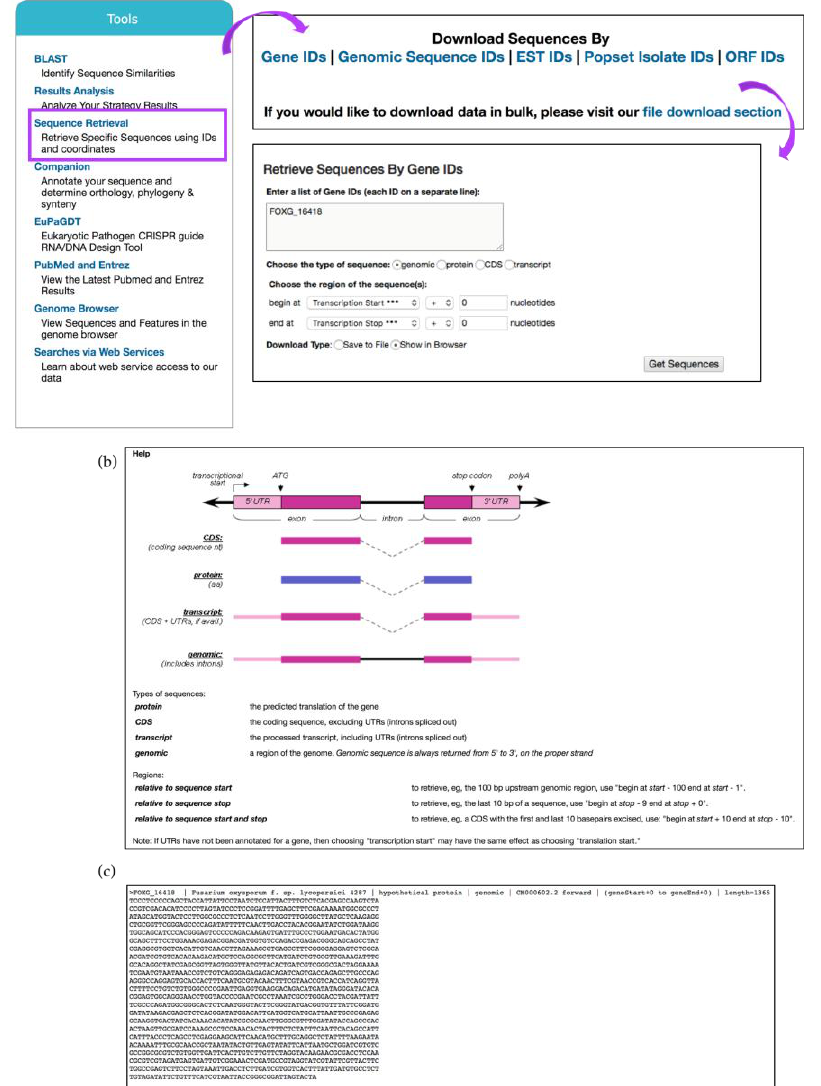
Figure 20. Sequence Retrieval Tool . ( a ) The tool can be initiated from the Tools component of the main page (highlighted in purple). Retrieving Sequences by Gene IDs is shown for gene FOXG_16418. Additional retrieval features are available: Retrieve Sequences By Genomic Sequence IDs , Retrieve Sequences By EST IDs , Retrieve Sequences By Popset Isolate IDs , Retrieve Sequences By Open Reading Frame IDs ; ( b ) Help menu at the bottom of the page offers guidance in identification and selection of transcriptional and translation start and stop sites; ( c ) Browser view of the results showing FASTA sequence for the genomic sequence for gene FOXG_16418.